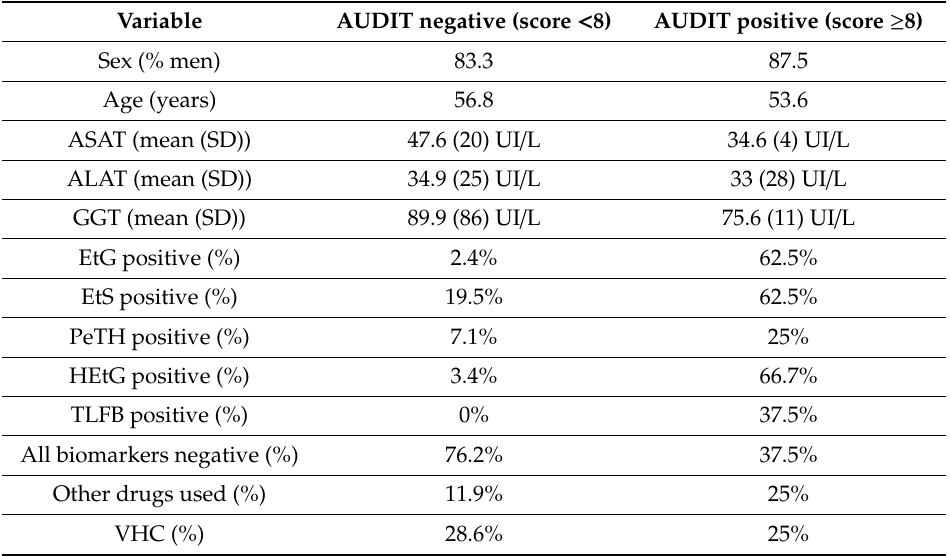
Table 1. Di ff erences between AUDIT negative and positive patients for the main variables of the study. Variable